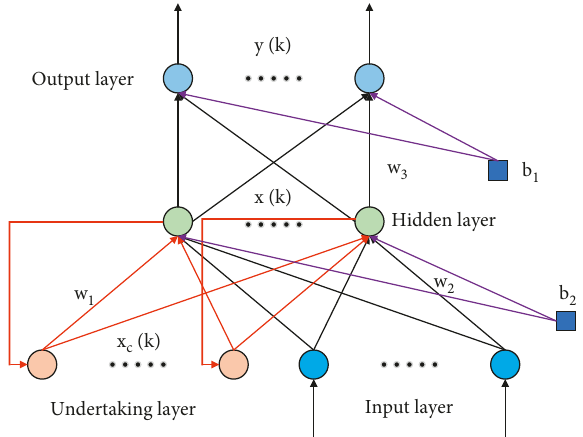
Figure 1: Elman artificial neural network structure